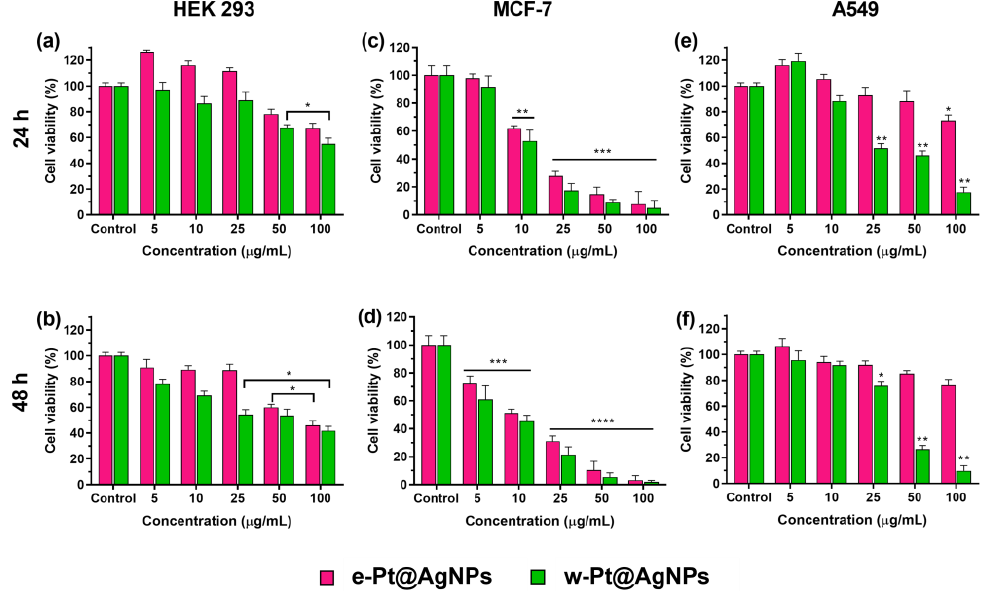
Figure 7. Cytotoxicity evaluation of e -Pt@AgNPs and w -Pt@AgNPs against ( a , b ) HEK 293, ( c , d ) MCF-7, ( e , f ) A549 cells incubated at 24 h and 48 h ( n = 3). Data are expressed as a percentage of the untreated cells (always 100%) and represented as the mean ± standard deviation (SD). Statistical significance denoted as * p < 0.05, ** p < 0.01, *** p < 0.005, **** p < 0.001 are compared to untreated controls.